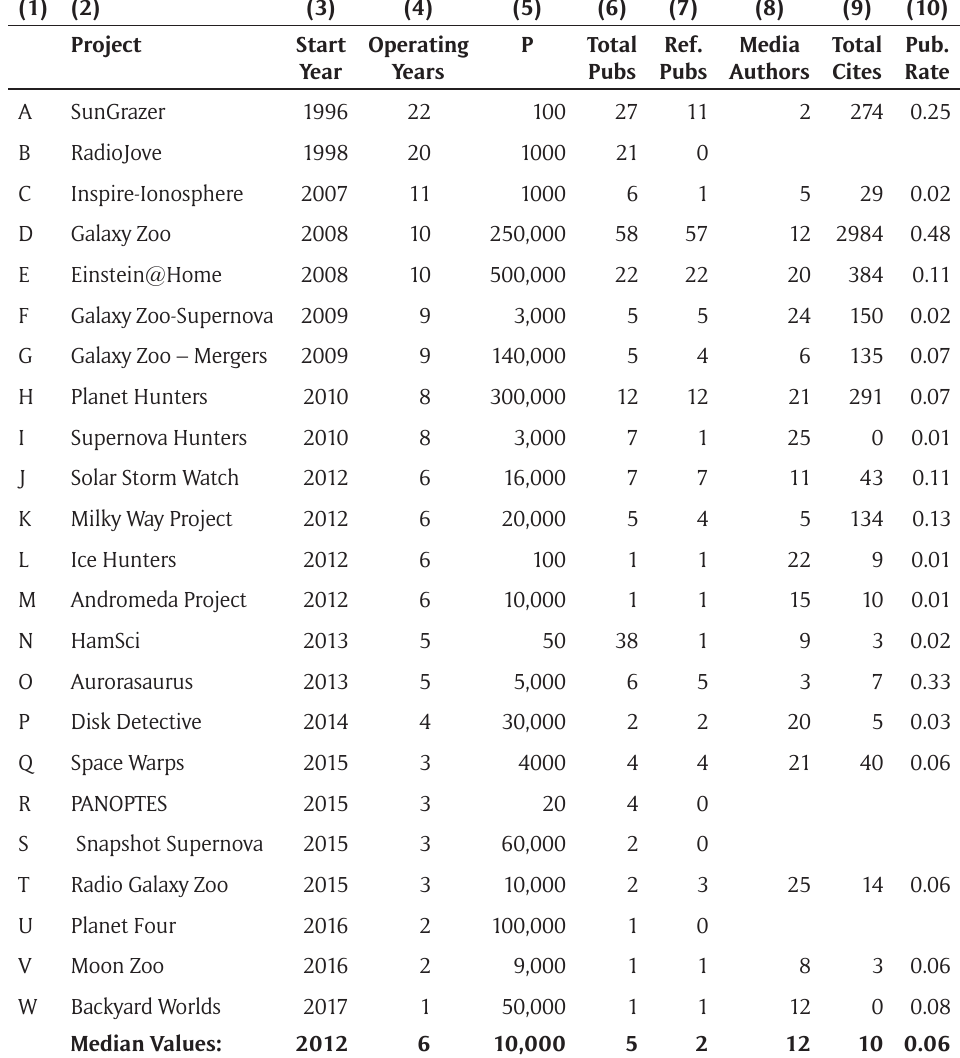
Table 2: Statistics for publications ordered by project start